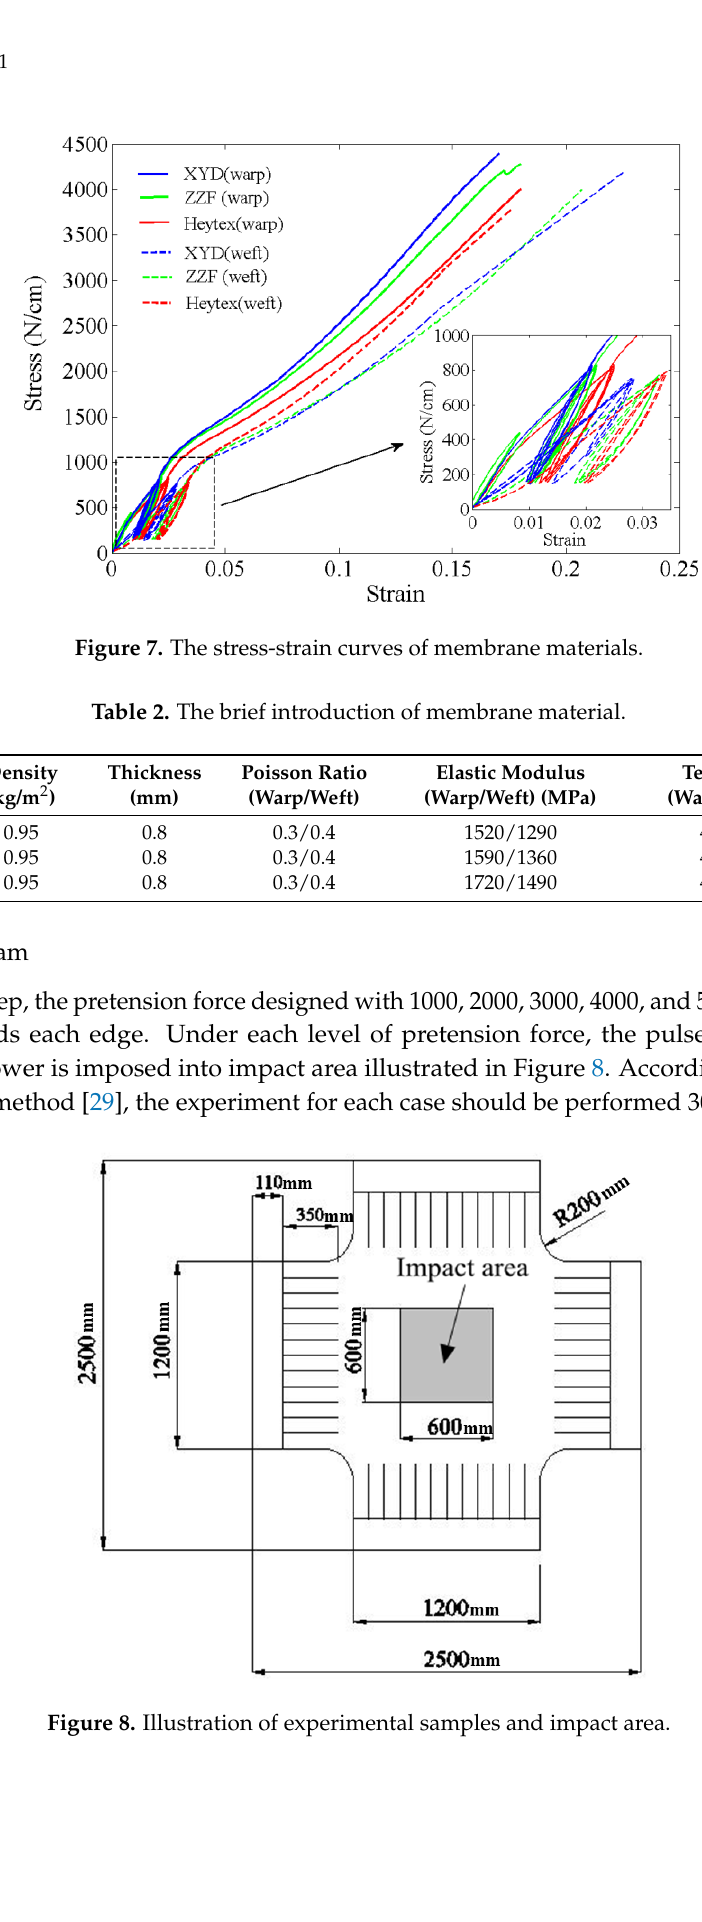
Figure 8. Illustration of experimental samples and impact area.